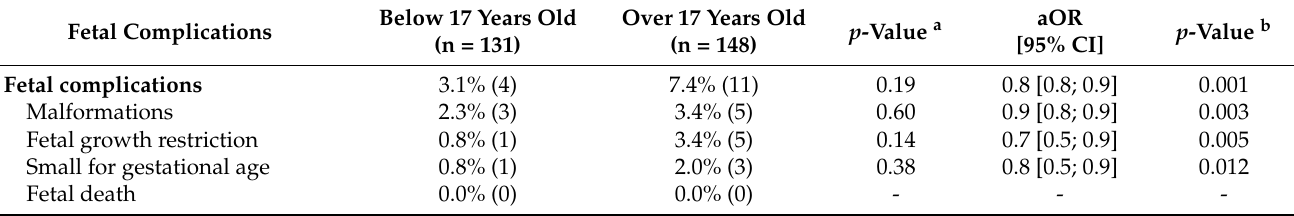
Table 3. Fetal complications during pregnancy according to maternal